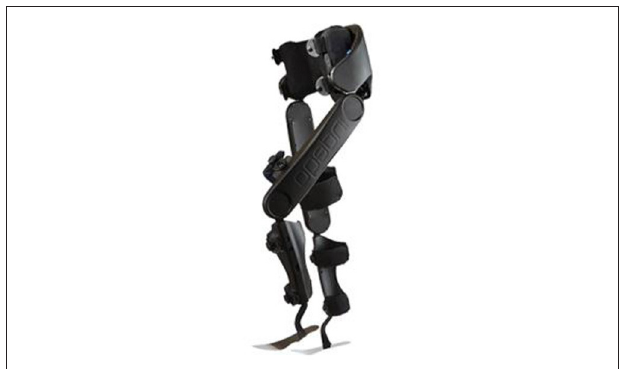
FIGURE 2 | Robotic exoskeleton (Indego) used for over ground walking (http://www.indego.com/).